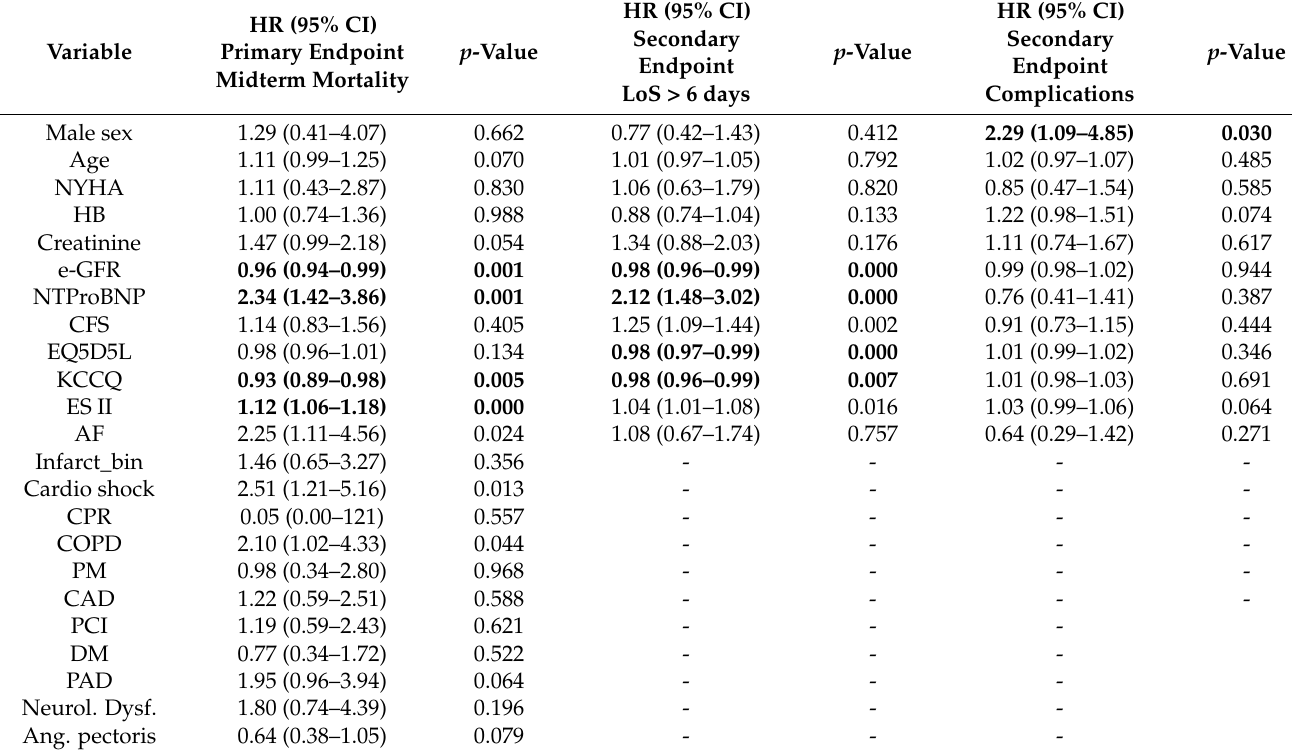
Table 2. Univariate analysis of the predictors for primary and secondary endpoints.